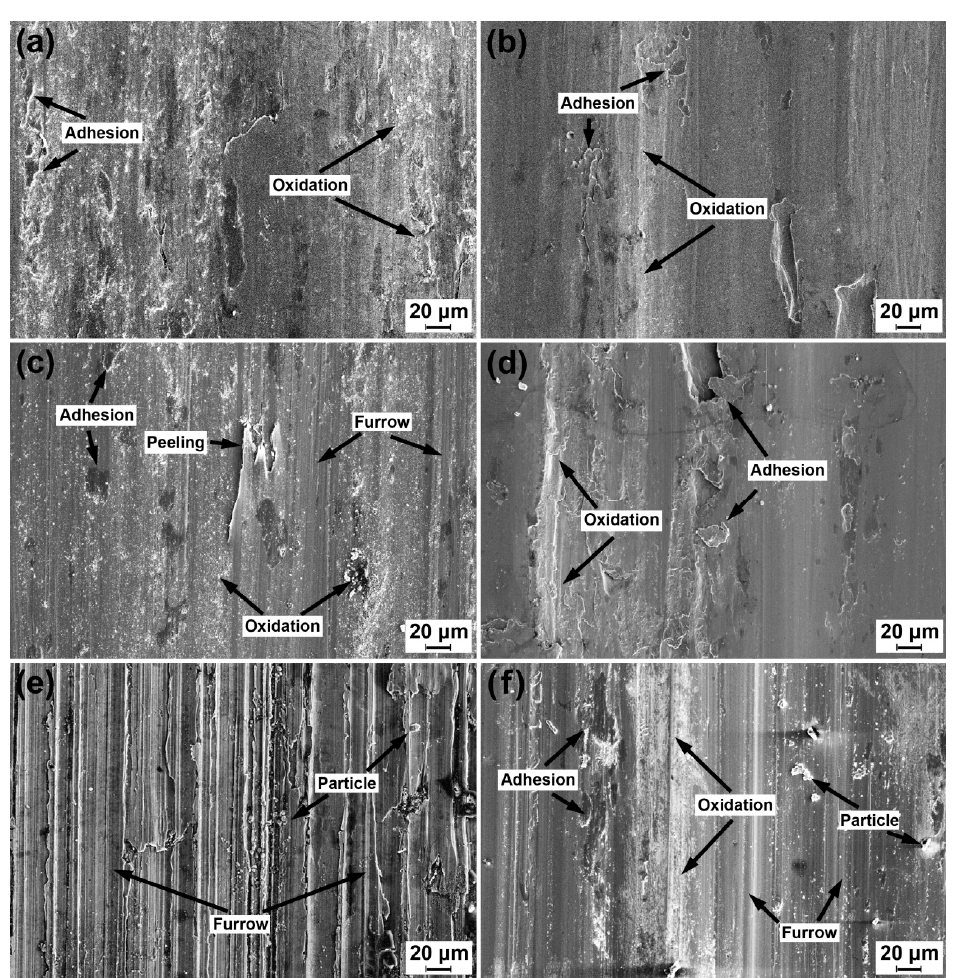
Figure 6. Scanning electron microscopy (SEM) micrographs of the worn surface of the ductile iron and carbon steel wheels under different loads at a sliding velocity of 6.3×10 4 mm/min: ( a ) D’, 50 N, ( b ) S, 50 N, ( c ) D’, 60 N, ( d ) S, 60 N, ( e ) D’, 70 N, and ( f ) S, 70 Table 6. Energy-dispersive X-ray spectroscopy (EDS) results of the worn surface of the ductile iron and carbon steel wheels at a sliding velocity of 6.3×10 4 mm/min under different loads.